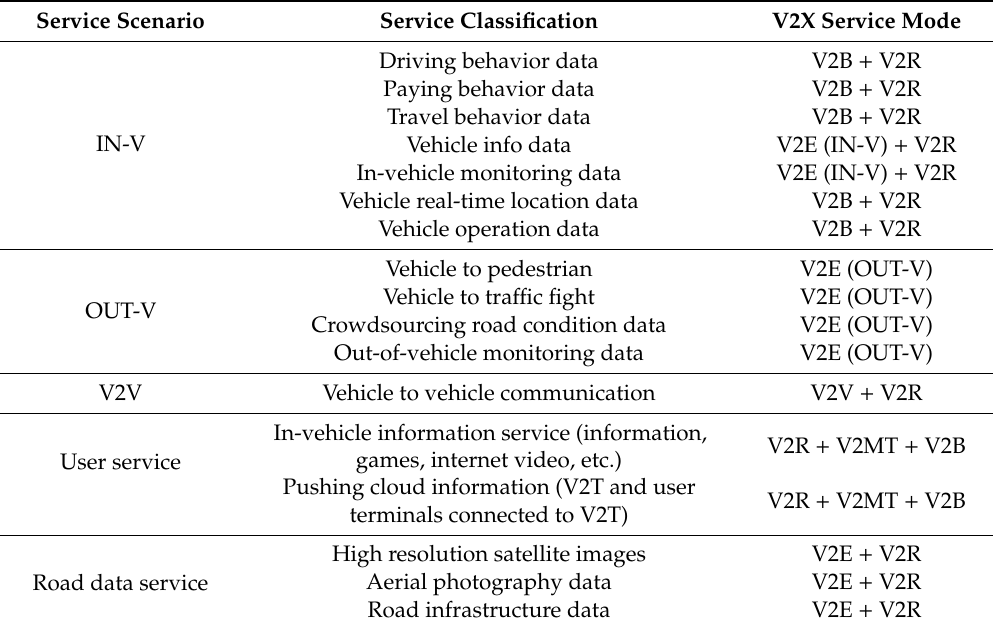
Table 1. V2X-based service